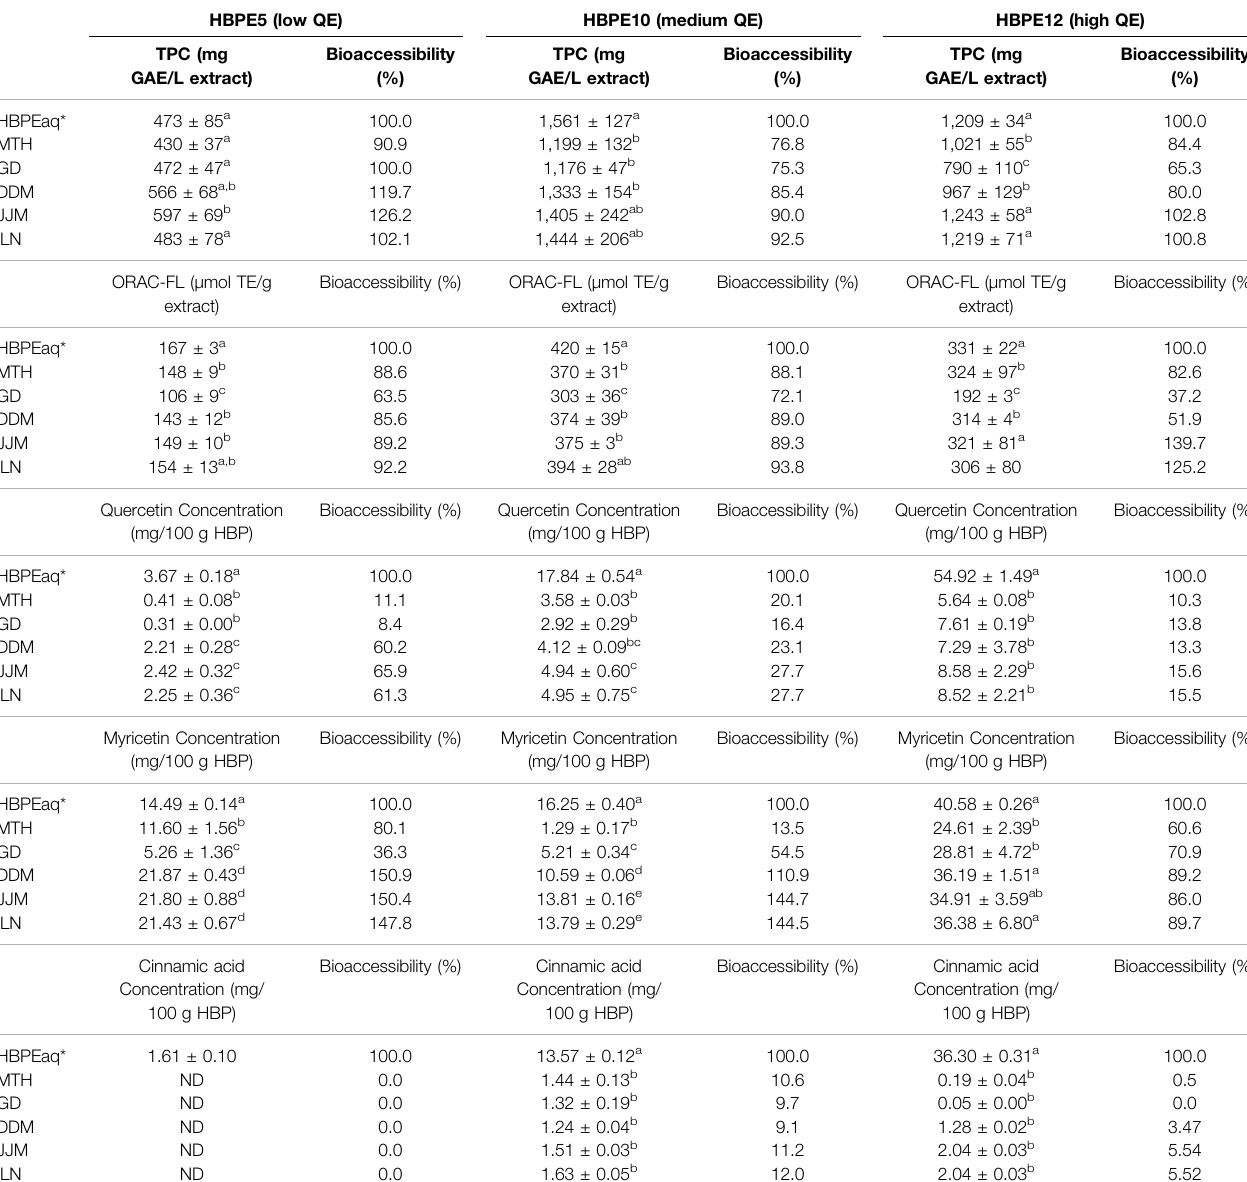
TABLE5| Totalphenoliccontent(TPC),antioxidantactivity(ORAC-FL),quercetin,myricetin,andcinnamicacidconcentrationatdifferentdigestionstepsinthebioaccessible fractions in honeybee pollen extracts (HBPEs). HBPE5 (low QE) HBPE10 (medium QE) HBPE12 (high QE) TPC (mg GAE/L